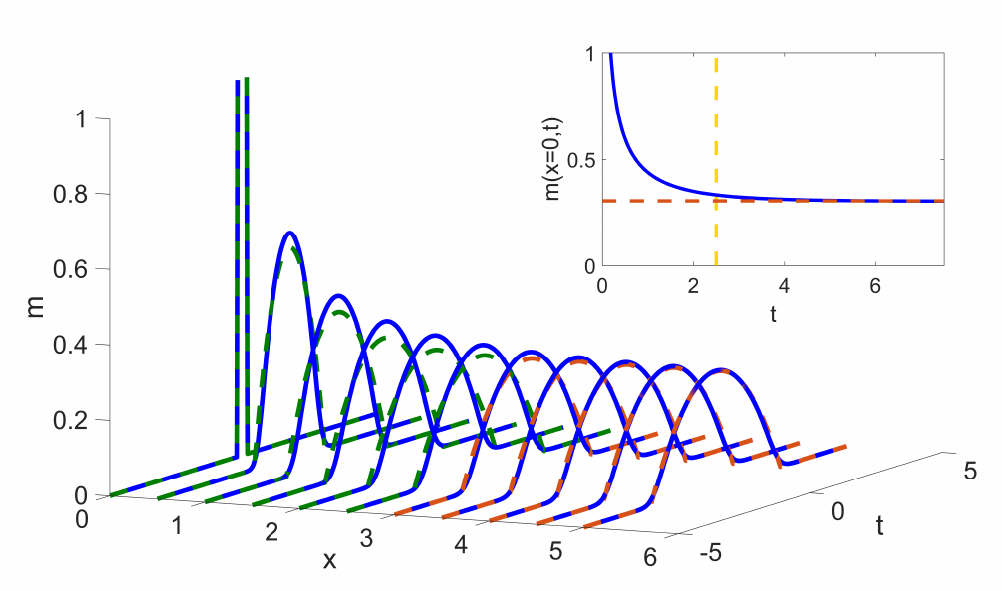
Figure 7: The full blue line represents the numerical density of players, the dashed green line is obtained through a parabolic ansatz of intrinsic time τ = ˜ T ( 3 / 2 ) 3 / 2 = 2.5 and the dashed red line corresponds to the ergodic den- IV sity. In the inset the full line shows the time evolution of the maximum of the player ( 0 ) , maximum of density m ( x = 0, t ) , while the dashed horizontal line is set at m er the density during the ergodic state, and the dotted vertical at t = τ = 2.5. Here = 0.2, E = − 0.36 and T = g = − 2, σ = 0.4, µ = 1, ω 2 0